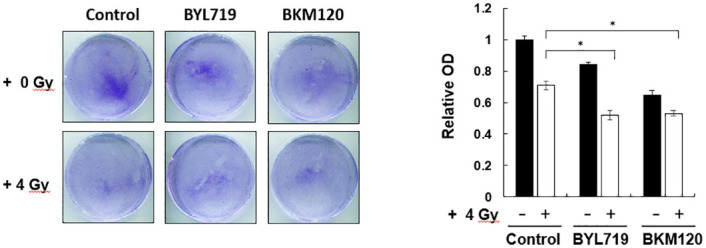
Radiosensitivity enhancement effect of combination treatment of PI3K inhibitors and IR in patient-derived cells.Patient-derived cells were derived from patients with OSCC. The cells were pretreated with BKM120 or BYL719 at 2 μM and then irradiated at 0 or 4 Gy. After 14 days, colonies were stained with crystal violet and quantified by an ELISA reader. Typical images of colony growth for the different treatments are shown. *P < 0.01 compared with the control group.